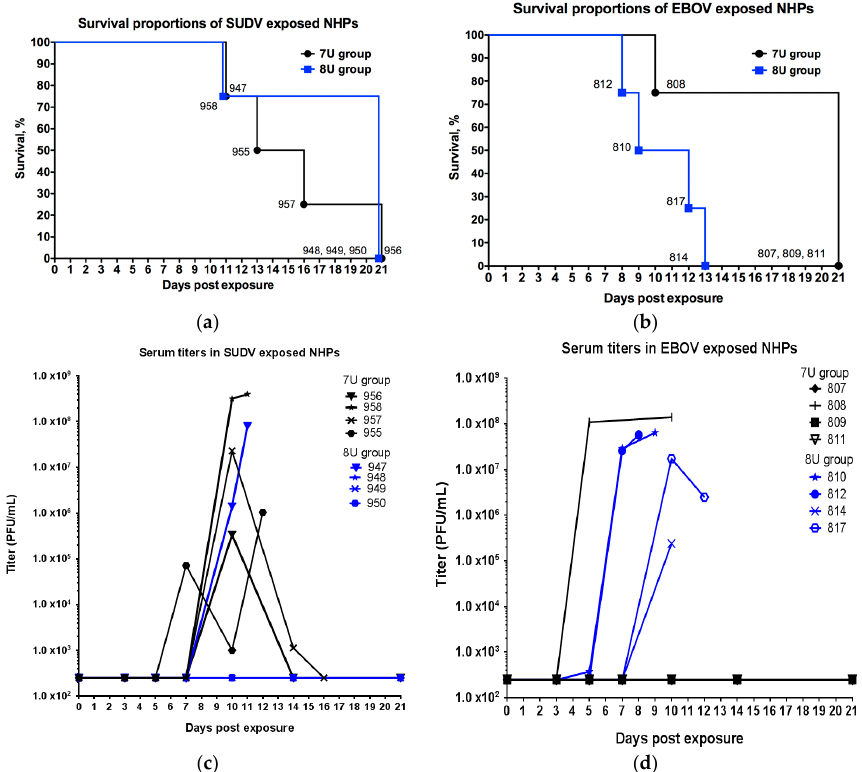
Figure 1. Survival and viremia in M. fascicularis experimentally exposed to 0.01 plaque-forming units of either Sudan virus (SUDV) or Ebola virus (EBOV) with 7-uridine (7U) or 8-uridine (8U)